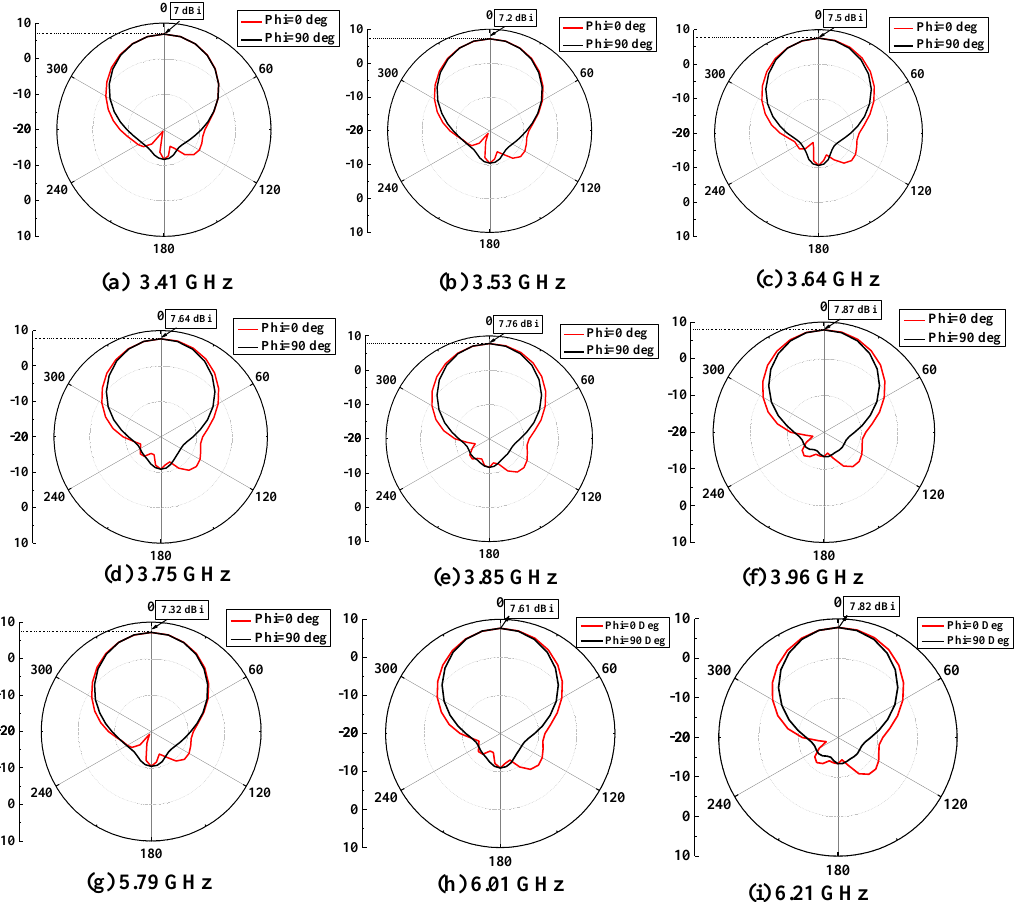
Figure 6. Radiation gain patterns of the antenna array in the xz plane and yz plane at different frequencies. The gain of the single patch antenna and the gain of the patch antenna array without any smaller side patches are simulated. The gains of the single patch antenna and the patch antenna array are shown in Figure 7. The gain of the single patch antenna is 4.4 dBi. Also, the gain of the single patch antenna array is 7.8 dBi. Therefore, the gain is improved by using the array. As a result, we updated the gains of the frequency reconfigurable antenna array.